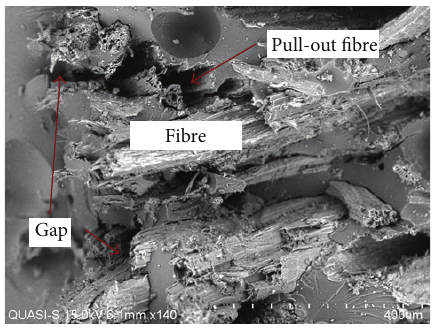
Figure 15: SEM analysis on random chopped kenaf